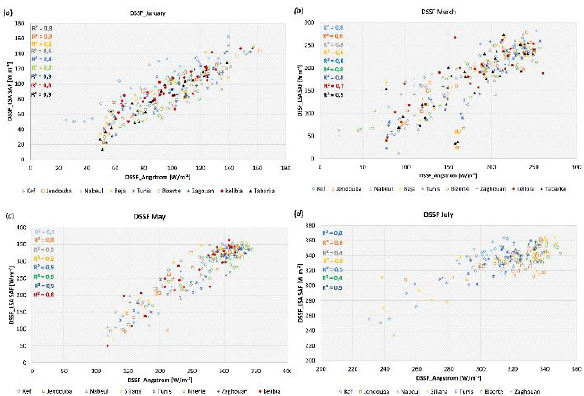
Figure 4 . Scatter plot of daily DSSF LSA SAF and R s calculated by Angstrom formula for (a) January, (b) March, (c) May and, (d) July